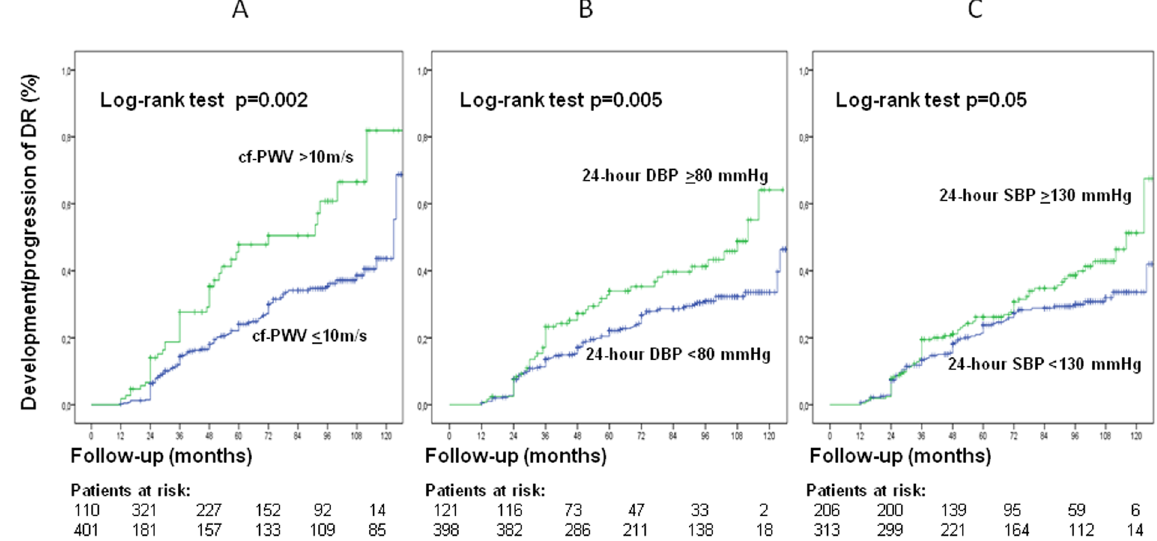
Figure 2. Kaplan-Meier estimation of cumulative diabetic retinopathy incidence or progression in type 2 diabetic patients grouped according to increased aortic stiffness (carotid-femoral PWV > 10 m/s, panel A), ambulatory 24-hour diastolic blood pressure ≥ 80 mmHg (panel B), and ambulatory 24-hour systolic blood pressure ≥ 130 mmHg (panel